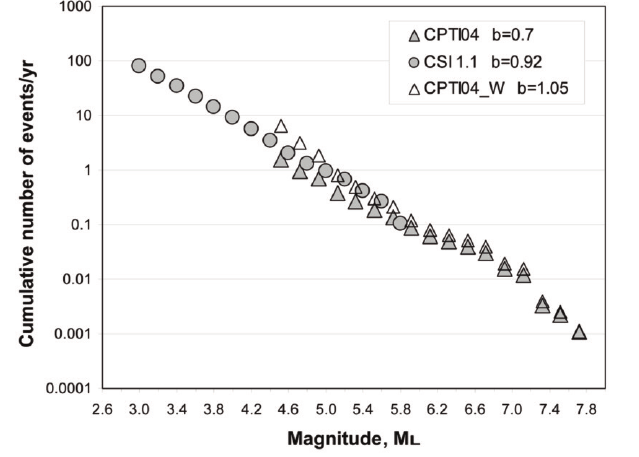
Figure 6. Cumulative number of events per year versus magnitude observed historically in Italy, CPTI04 (gray triangles), and the predicted rates using the Weicherst method, CPTI04_W (red triangles), and the cumulative number of events per year obtained from the CSI 1.1 instrumental catalog (gray